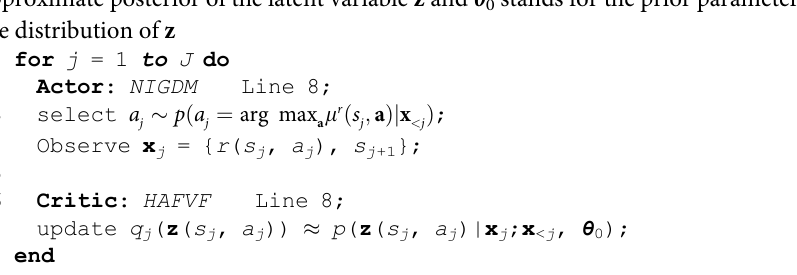
, a ) and transition s 0 = T ( s , j j j stands for the prior parameter values of 0